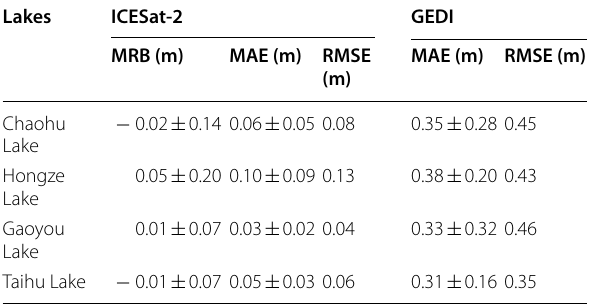
Table 2 The evaluation of ICESat-2 and GEDI versus the in situ water levels acquired at nearly the same time